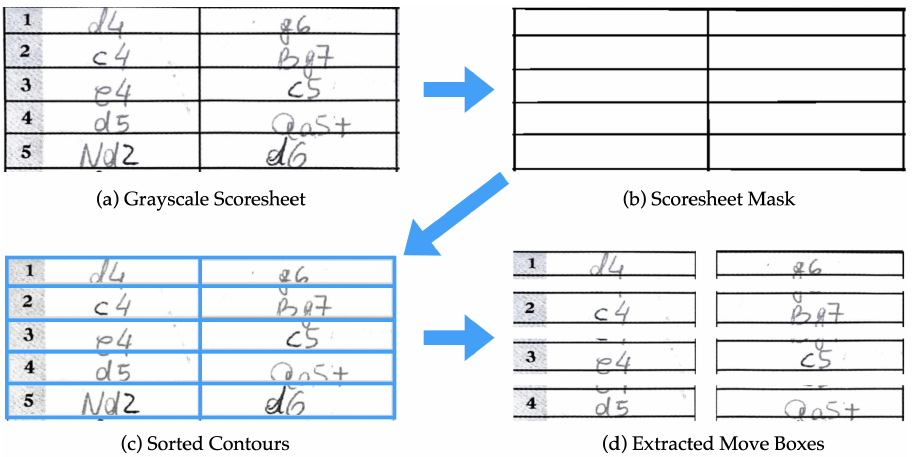
Figure 3. Stages of move-box extraction: ( a ) grayscale image; ( b ) morphological operations to generate a mask; ( c ) contour detection and sorting from the mask; ( d ) sorted contours cropping with top and bottom padding of 15% and 25%.